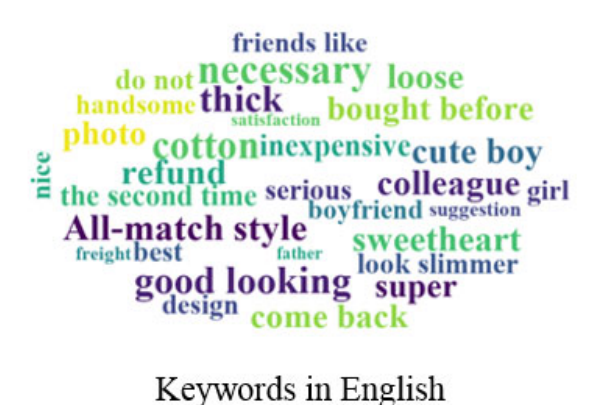
Figure 5. The most different words under different product consideration (10 products).